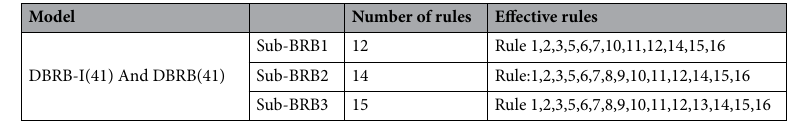
Table 5. The DBRB-I model rules.